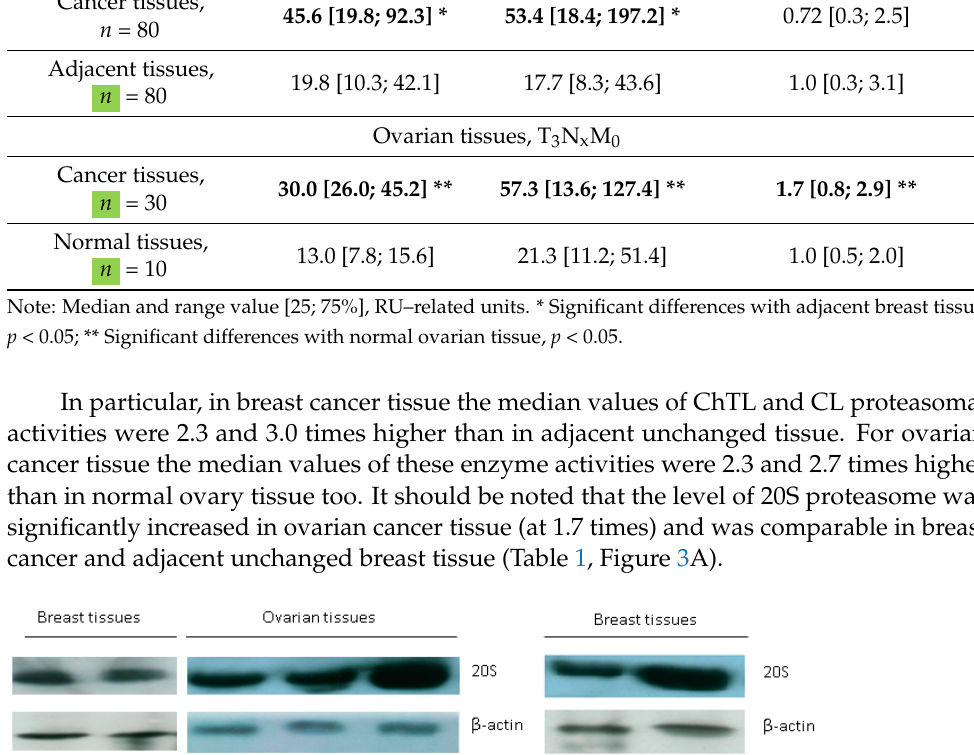
Table 1. Proteasomal activity and the level of 20S proteasome in breast and ovarian cancer tissues. Biological Sample